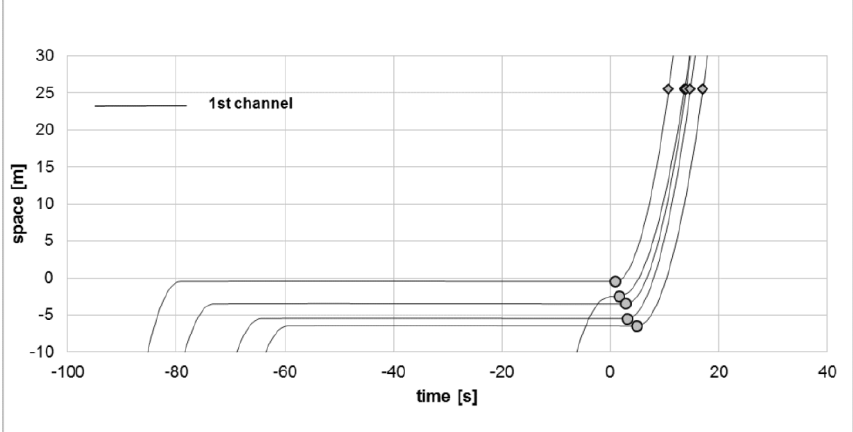
Figure 13. Space-time diagram for cyclists in the Q(5,1) single-channel